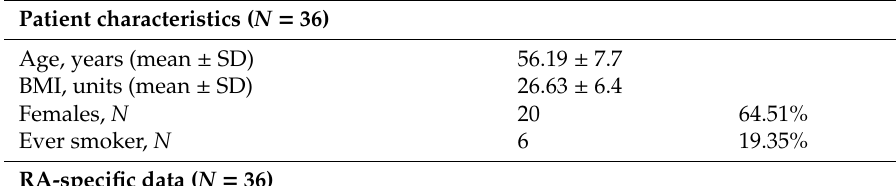
Table 2. Patient data and current treatment of study subjects.